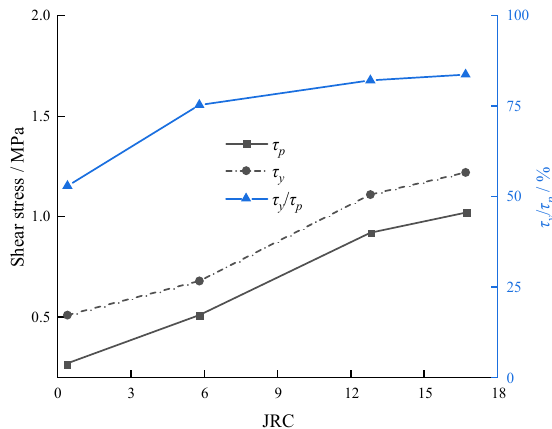
Figure 16. Yield stresses under the high velocity impact (Note: τ p data are from Fan et al. [80]).